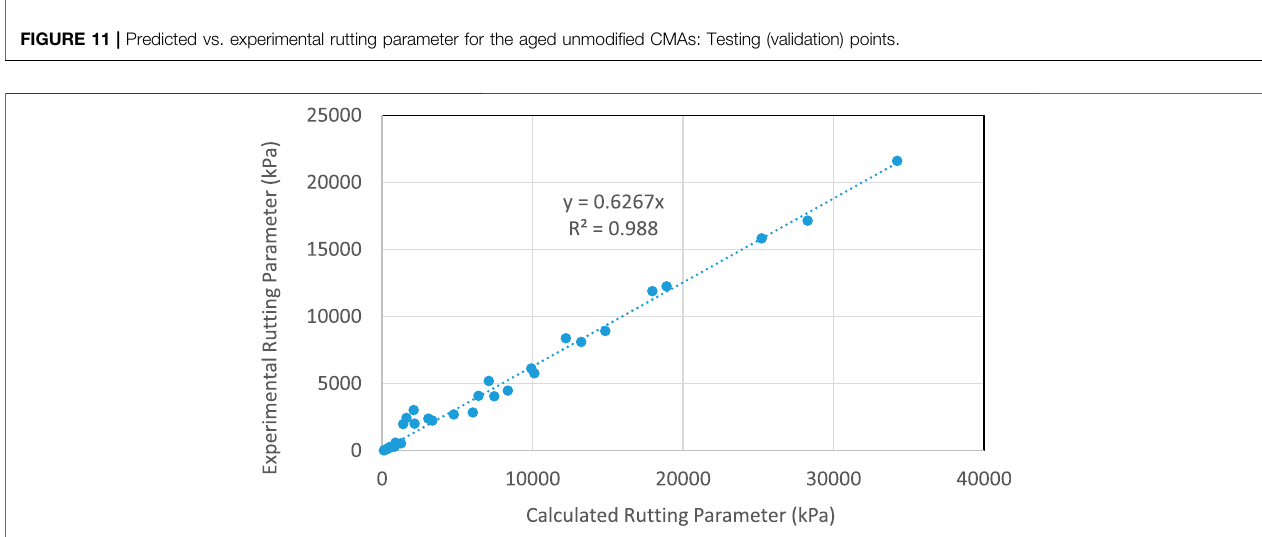
Frontiers in Built Environment |